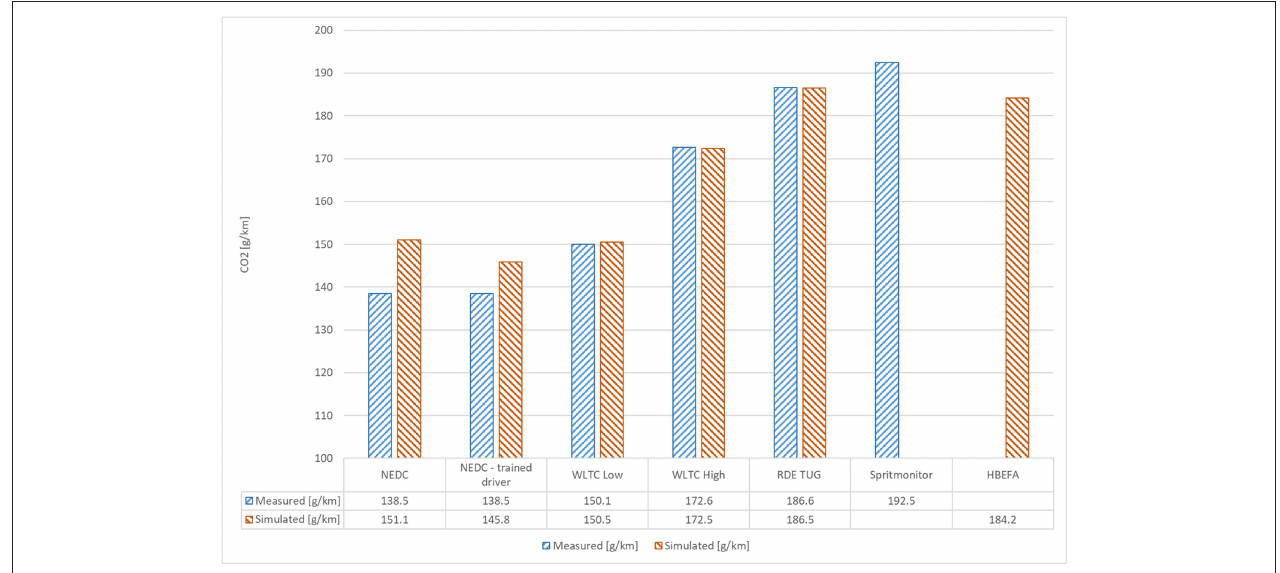
FIGURE 6 | Average of measured and simulated CO 2 emissions for the sample of four gasoline EURO 6 cars (Opetnik, 2019).